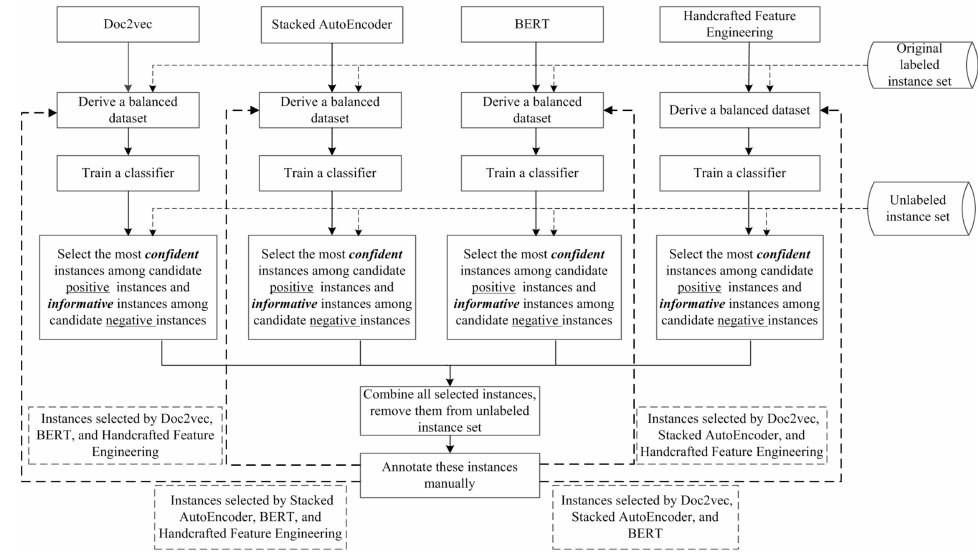
Figure 1. Framework of the proposed